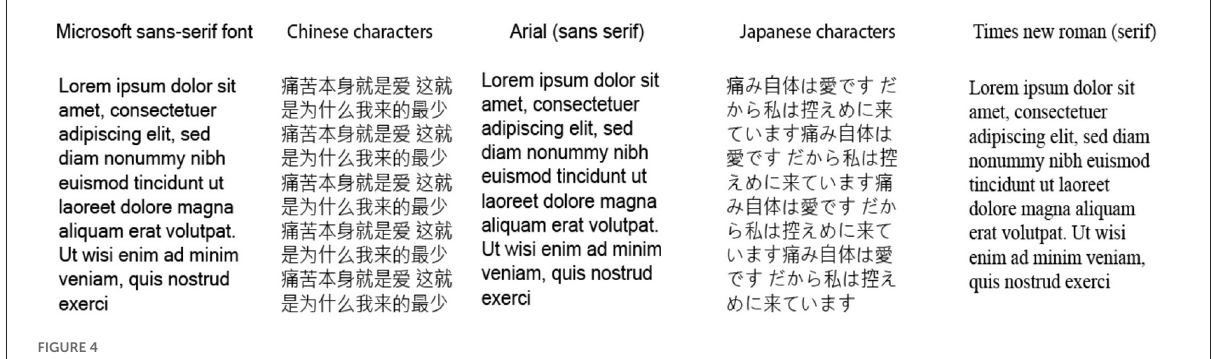
FIGURE4 Specific fonts and font style as detailed in Table